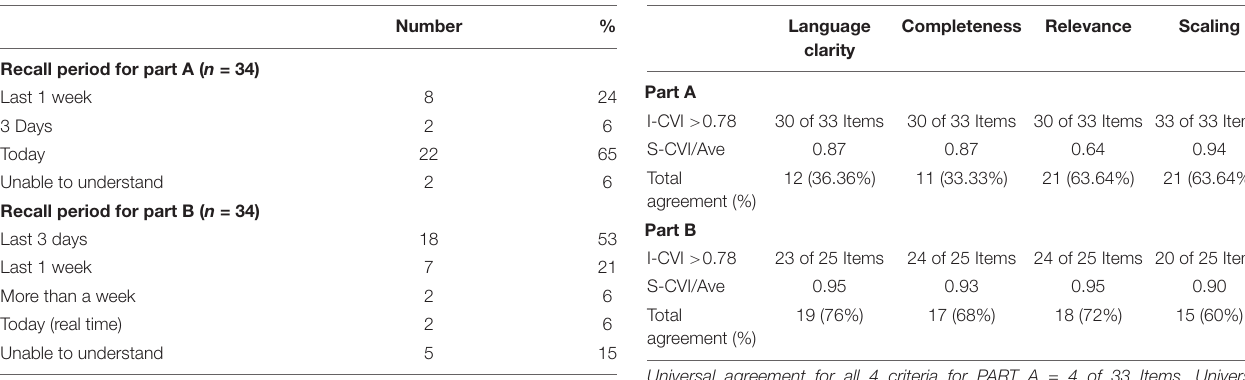
TABLE 4 | Study patients’ perspective of recall period ( n = 34).